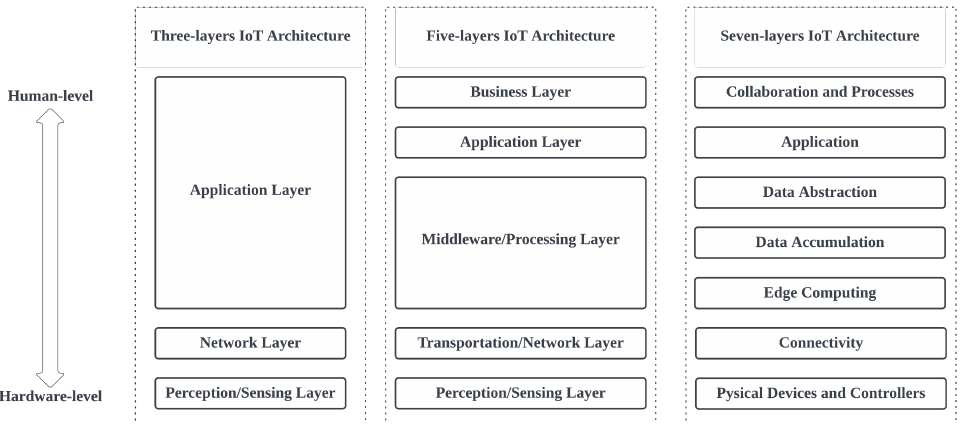
Figure 1. IoT architectures commonly discussed in the literature. The three-layer IoT architecture, five-layer IoT architecture, and seven-layer IoT architecture are the most commonly discussed IoT architectures in the